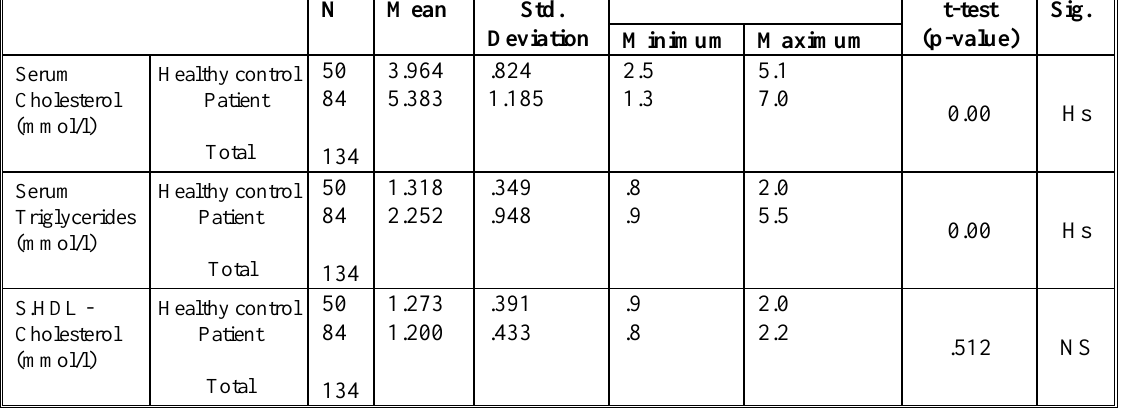
Table 3 : Mean distribution of (Cholesterol, Triglyceride & HDL- Cholesterol) concentration in the studied groups .